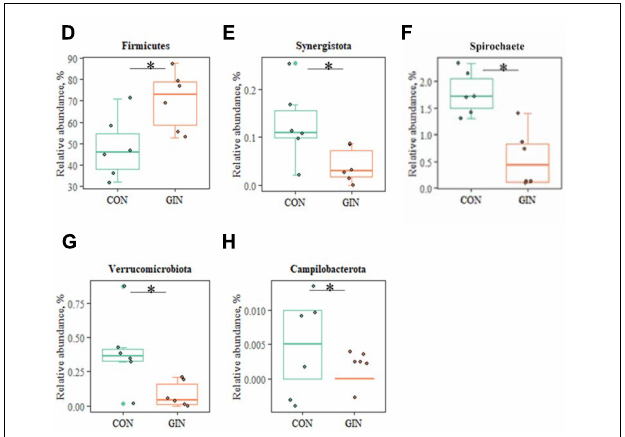
FIGURE 4 | The top 10 phyla and other phyla of the rumen, abomasum and duodenum of lambs infected with Haemonchus contortus. (A–C) The top 10 phyla in the rumen, abomasum and duodenum; (D) significantly different phyla in the duodenum; (E–H) significantly different phyla in abomasum. ∗ P <